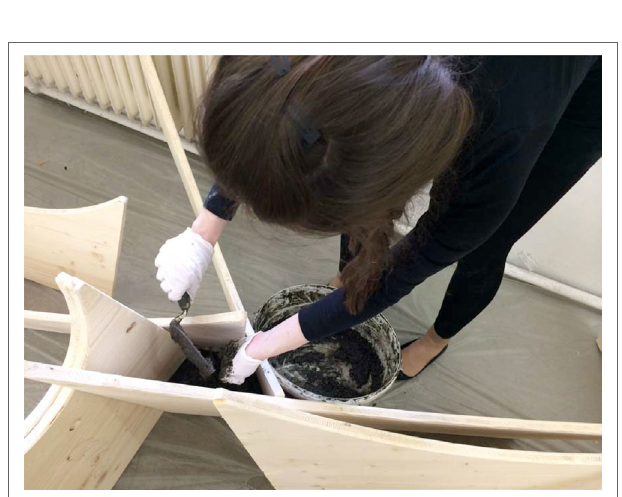
FIgURe 8 | Polymer concrete pouring.